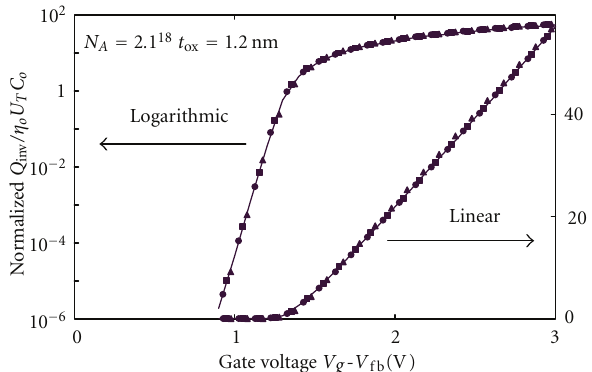
Figure 6: Normalized inversion charges Q inv ( Vg , V D = 0) η 0 C 0 U T versus Vg in logarithm and linear scales. ( − ) (11), ( (cid:2) ) (17), ( • ) (23), and ( (cid:3) ) (7a) and (7b) in